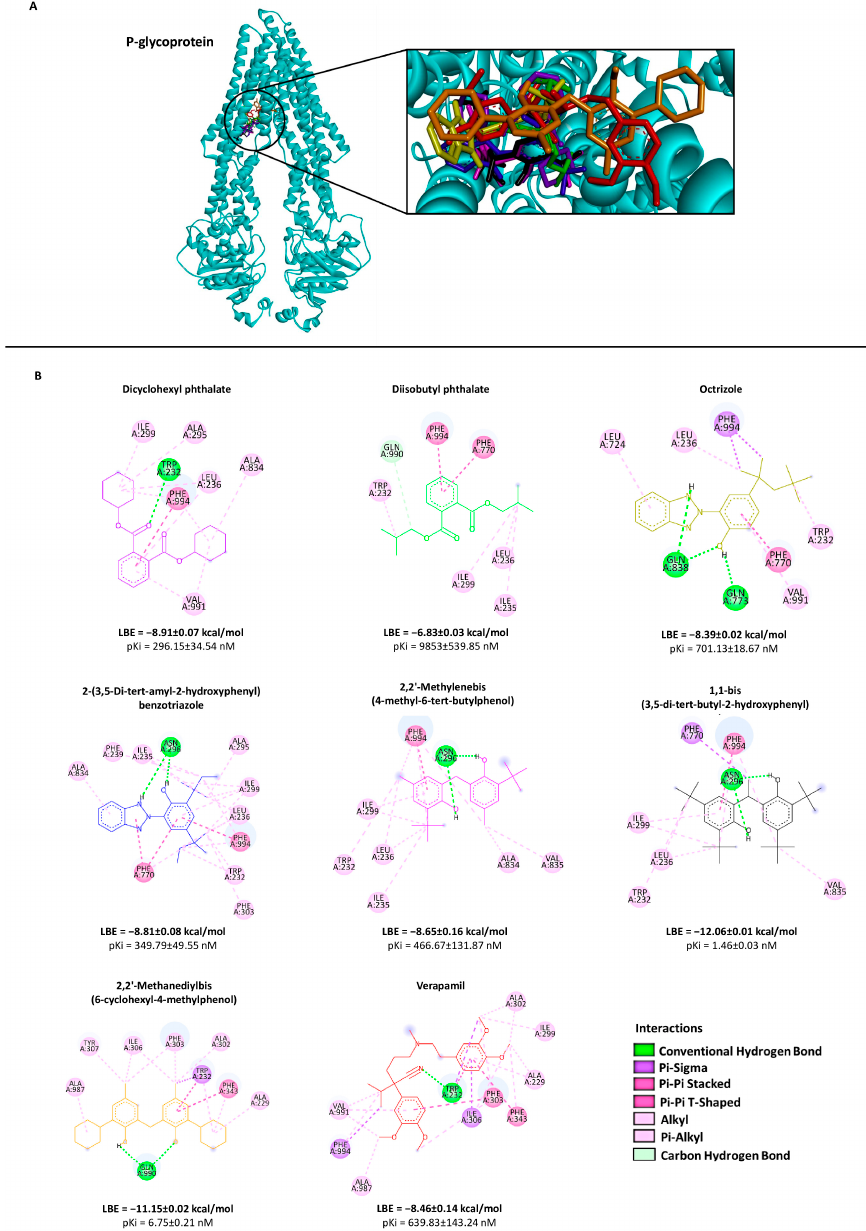
Figure 2. Representation of the binding mode between seven selected compounds and P-gp. ( A ) Three-dimensional structure of a P-gp model (cyan) and the lowest-energy conformation of the selected compounds and the positive control verapamil docked onto the P-gp drug-binding pocket. ( B ) Two-dimensional representation of the different types of interactions formed between the predicted interactive amino acids of P-gp and the respective selected compounds as visualized by Discovery Studio Visualizer V 21.1.0.20298 (Dassault Systemes Biovia Corp, San Diego, CA, USA). The lowest binding energies (LBE) as well as the predicted inhibition constant (pKi) values for each compound with P-gp are shown based on the molecular docking results obtained from AutoDock- Tools V 1.5.6 (The Scripps Research Institute, La Jolla, CA,USA). Verapamil was used as a positive control. Chemical structures are displayed according to the color code in panel ( A ).